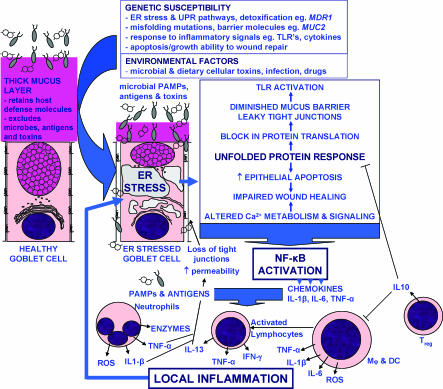
A Model for ER Stress in the Pathophysiology of Intestinal InflammationThis model recognizes that genetic and environmental factors can combine to invoke ER stress, reduced mucus production, and inflammation. Local inflammation can then exacerbate ER stress, potentially establishing a chronic cycle of inflammation in susceptible individuals. Abbreviations: ER, endoplasmic reticulum; Mϕ, macrophage; MDR1, multi-drug resistance gene 1; PAMP, prokaryocyte-associated molecular pattern; ROS, reactive oxygen species; TLR, toll-like receptor; UPR, unfolded protein response.